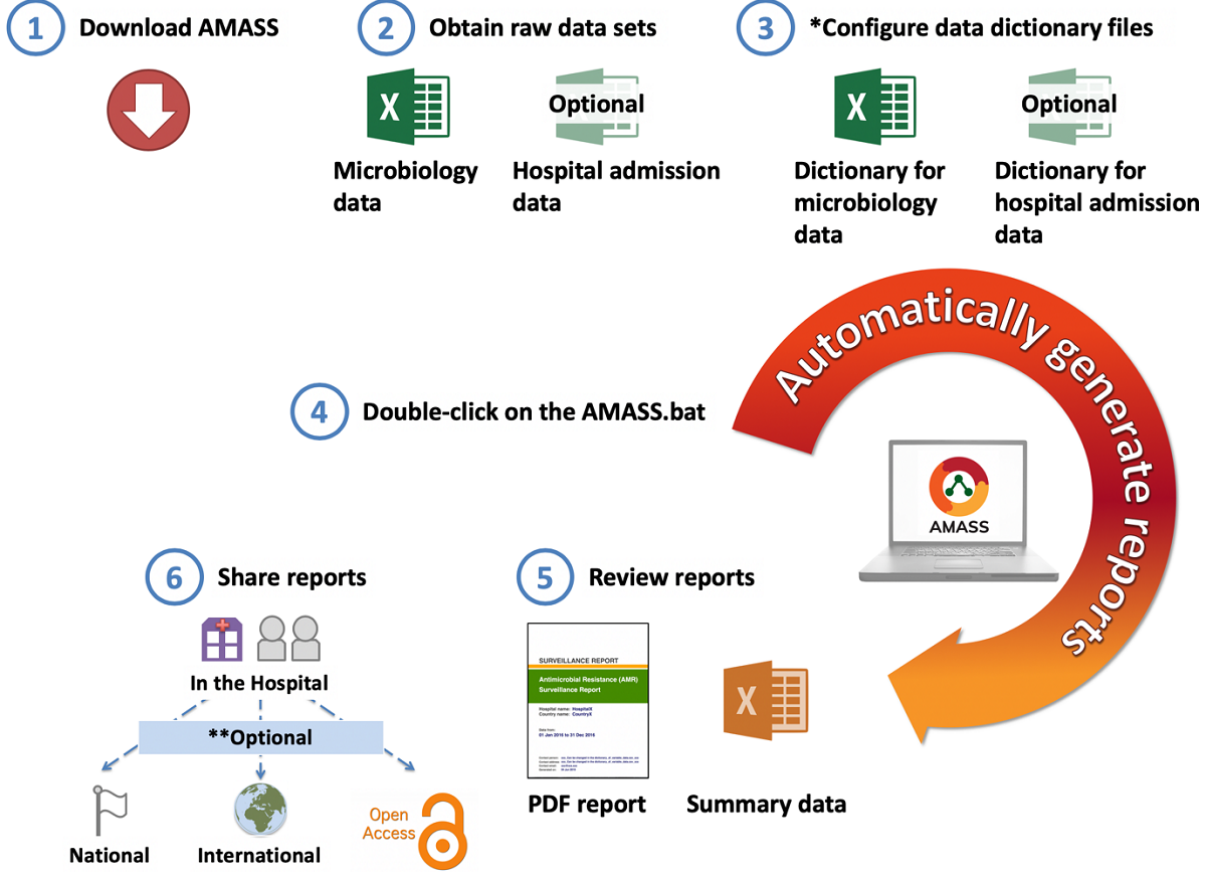
Figure 1. Conceptual flow of the AutoMated tool for Antimicrobial resistance Surveillance System (AMASS). Step 1 (download the AMASS)